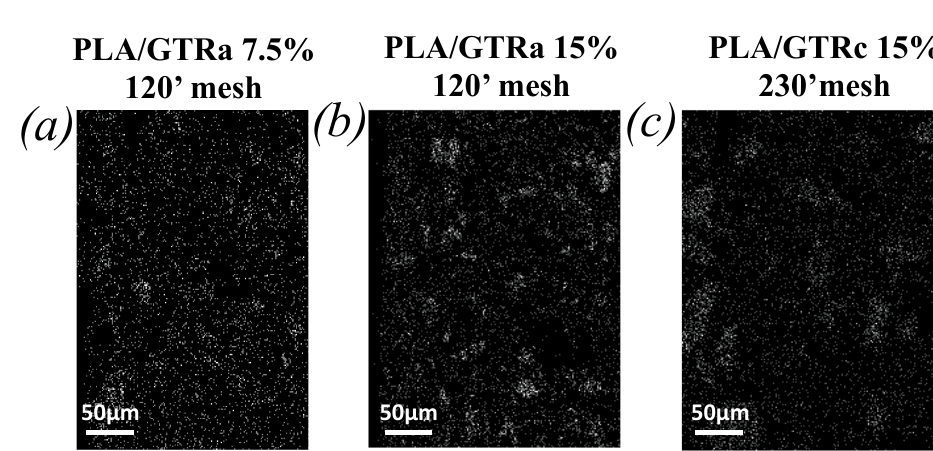
Figure A1. SEM ‐ EDX images of fracture surface of PLA/GTR a 7.5 wt% 120’s mesh with DCP ( a ), Figure A1. SEM-EDX images of fracture surface of PLA/GTR a 7.5 wt% 120’s mesh with DCP ( a ), PLA/GTR a 15 wt% 120’s PLA/GTR a 15 wt% 120’s mesh with DCP ( b ), PLA/GTR c 15 wt% 230’s mesh with DCP ( c ). mesh with DCP ( b ), PLA/GTR c 15 wt% 230’s mesh with DCP ( c